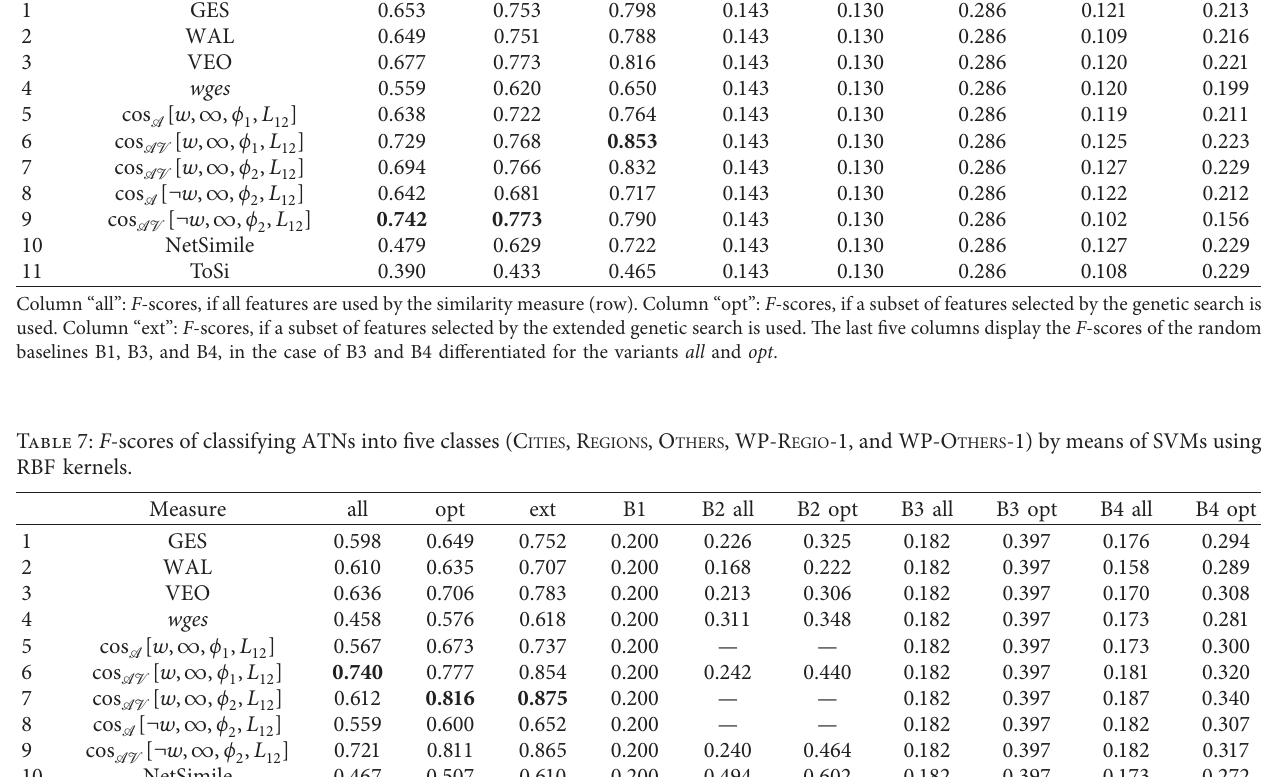
Table 6: F -scores of classifying TTNs into seven target classes (C ITIES , R EGIONS , O THERS , WP-R EGIO -1, WP-R EGIO -2, WP-O THERS -1, and WP-O THERS -2) by means of SVMs using RBF kernels. Measure all